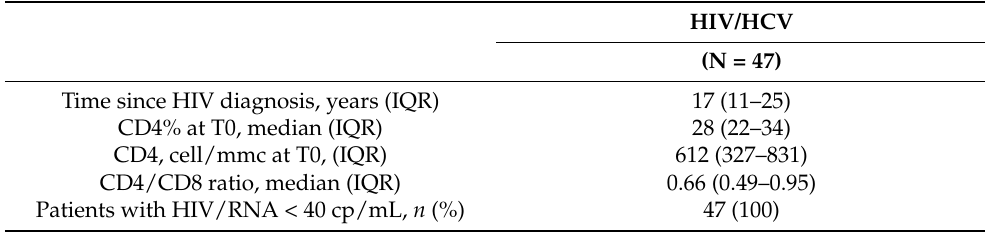
Table 2. HIV-related parameters in the HIV-HCV co-infected